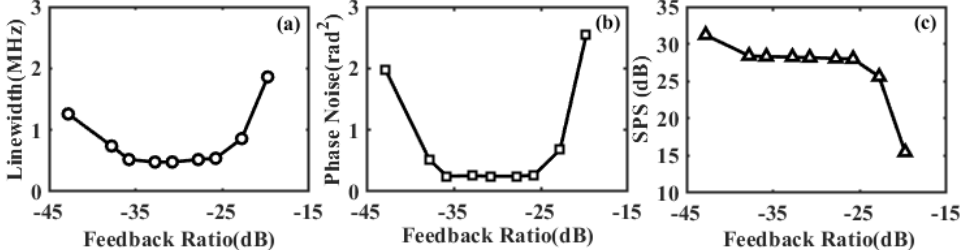
Figure 7. ( a ) Linewidth, ( b ) phase noise variance, and ( c ) side peak suppression of the generated microwave as a function of the feedback ratio. The injection parameters ( ∆ f , ξ inj ) are (15 GHz, 0.92).